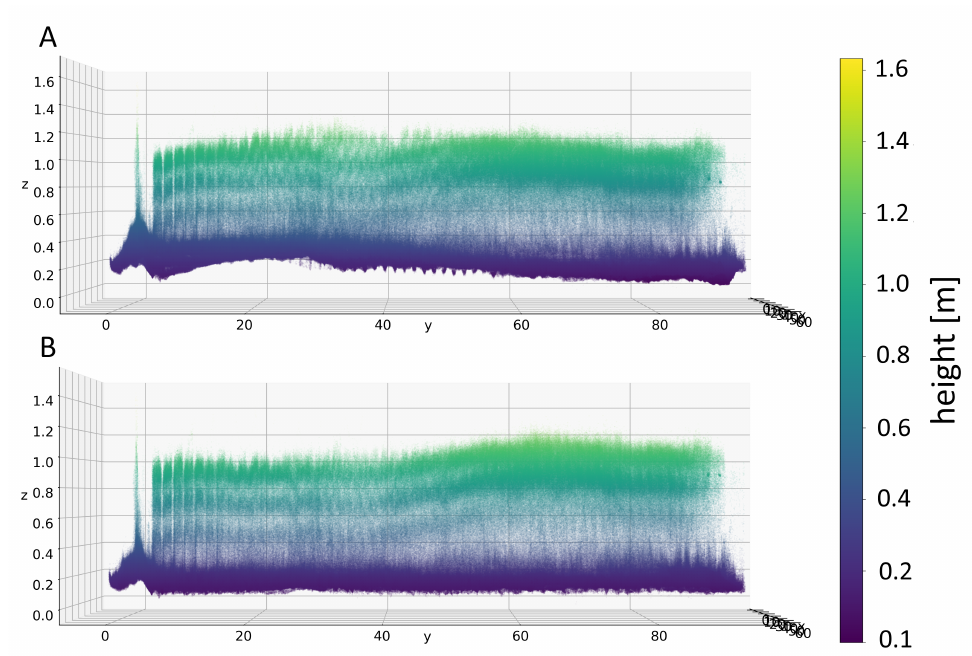
Figure 5. Terrain profile in an ROI that was analysed ( A ) before and ( B ) after terrain